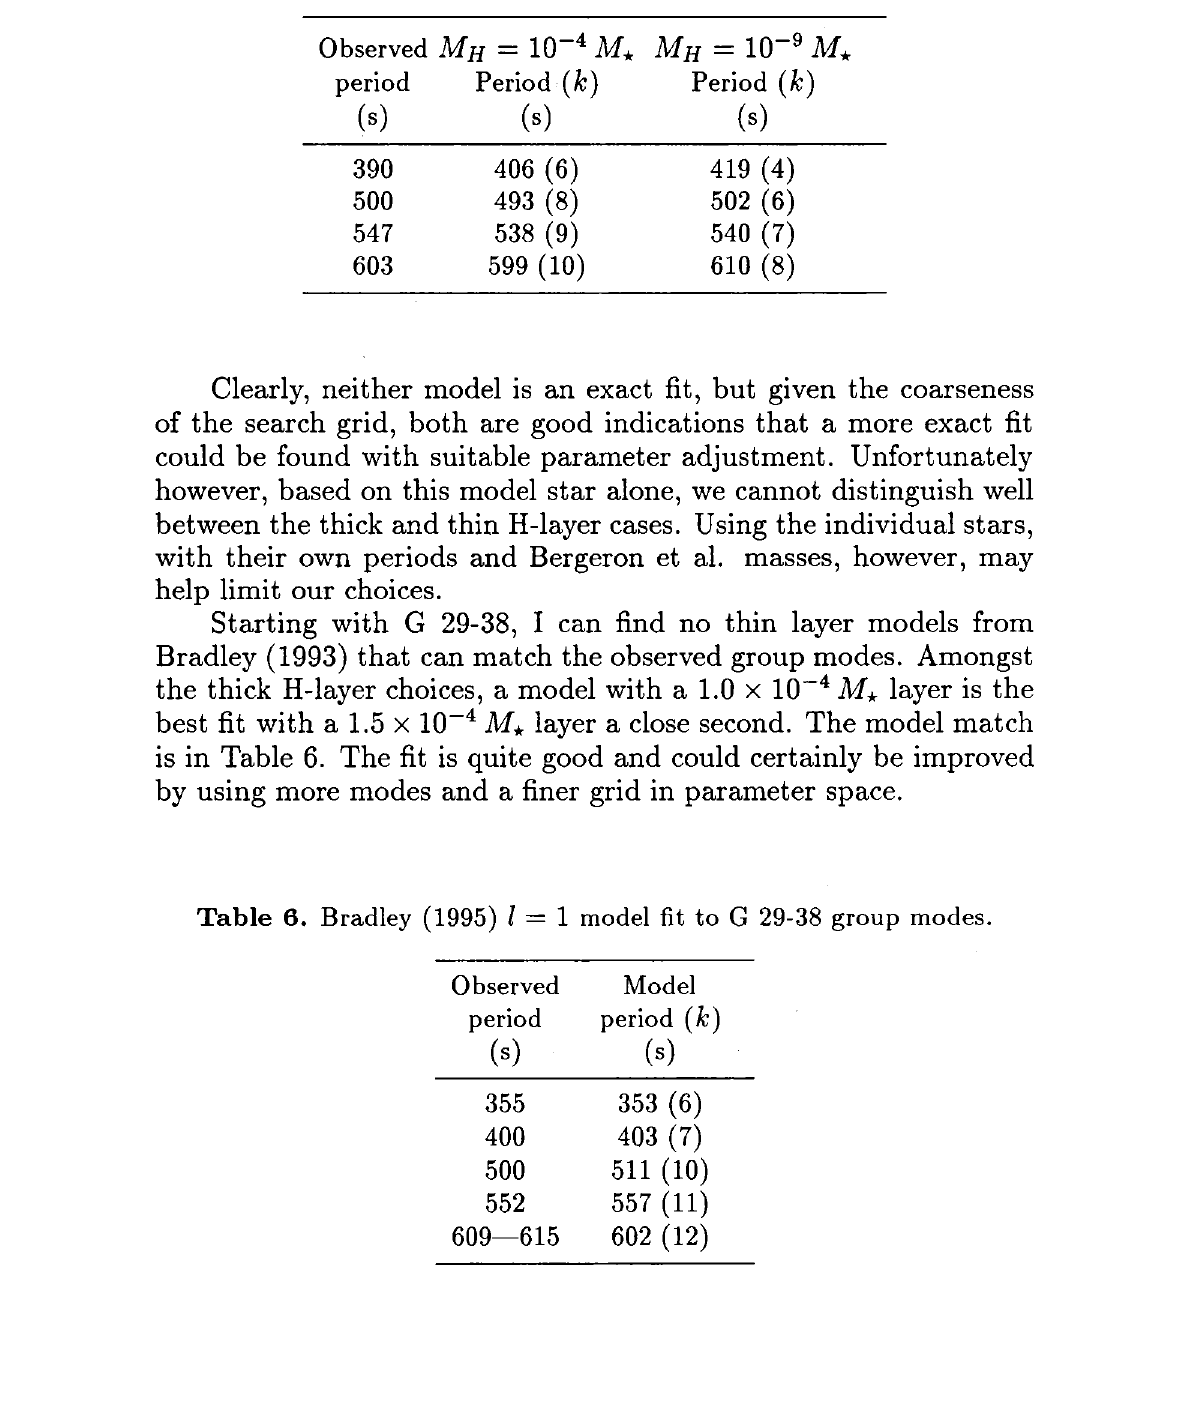
Table 5. Bradley (1993, 1995) t = 1 model fits to fictional